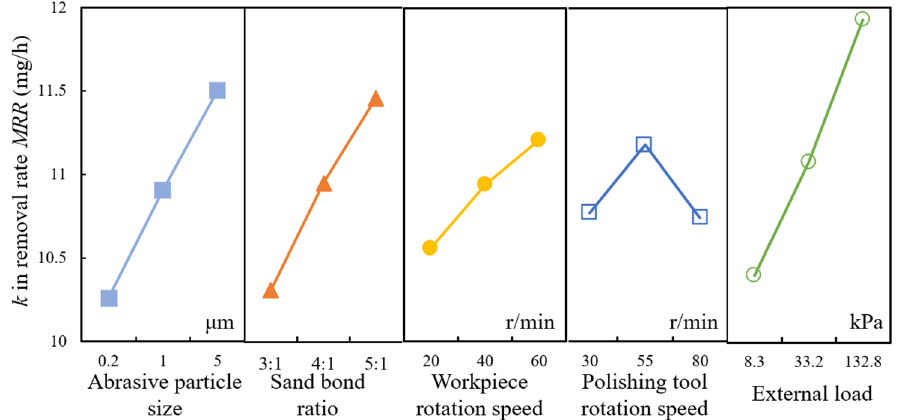
Figure 8. Relationship between parameters and material removal rate MRR.